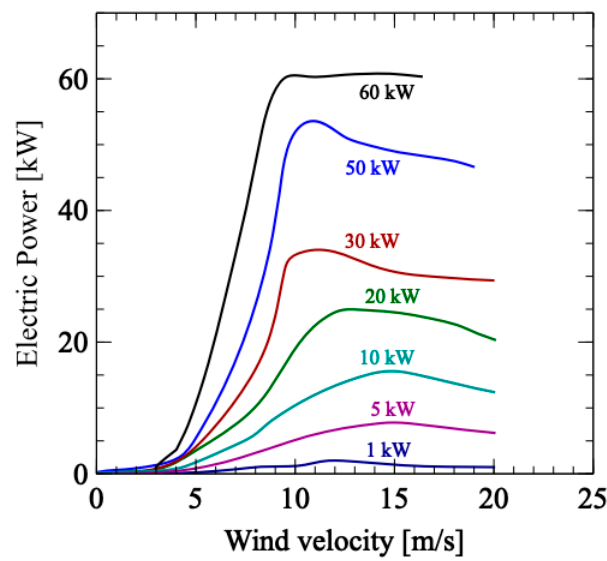
Figure 4. Wind speed–power curve of the selected WT units.